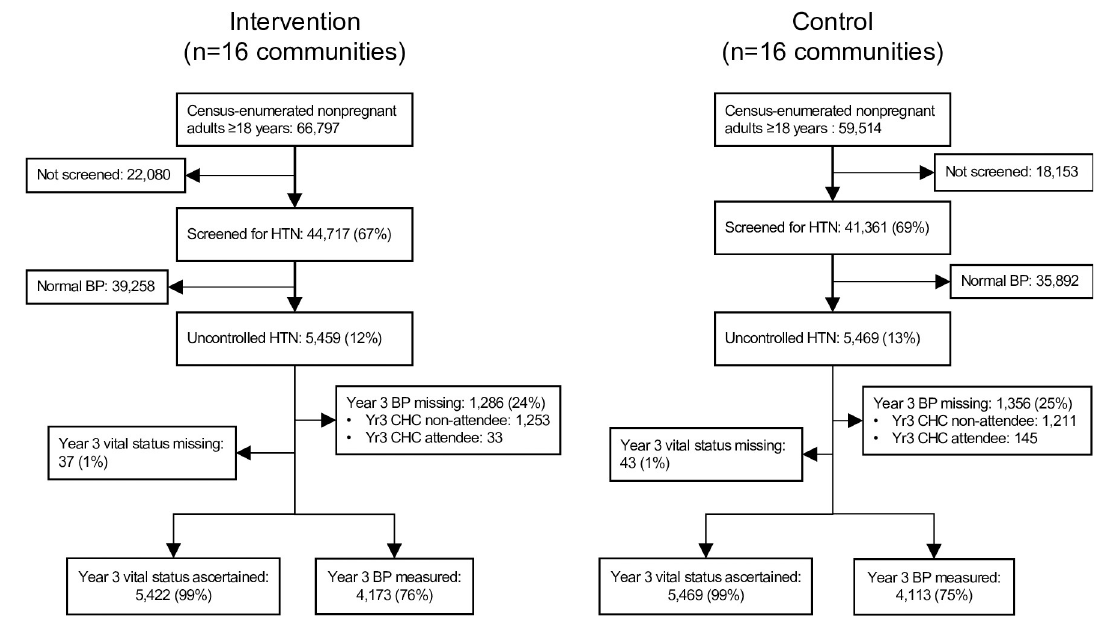
Fig 1. Study flow diagram. Baseline and year 3 BP was measured at CHCs. Vital status was measured in all study participants regardless of CHC participation. BP AU : TheabbreviationlistsinFigs 1 (cid:0) 6 havebeenupdated : Pleaseverifythattheaddedentriesarecorrect : , blood pressure; CHC, community health campaign; HTN, hypertension; yr3, year 3.